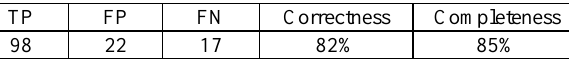
Table 1. Correctness and Completeness of window extraction